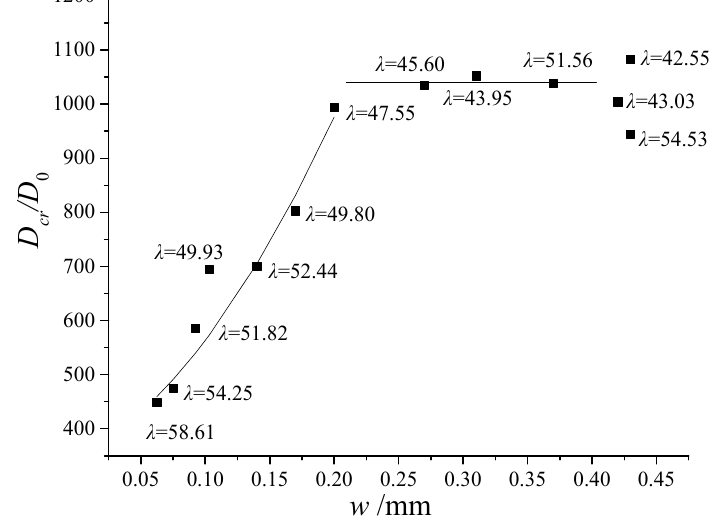
Figure 12. E ff ect of w and λ on di ff usion coe ffi cient through the λ Figure 12. Effect of w and on diffusion coefficient through the crack.